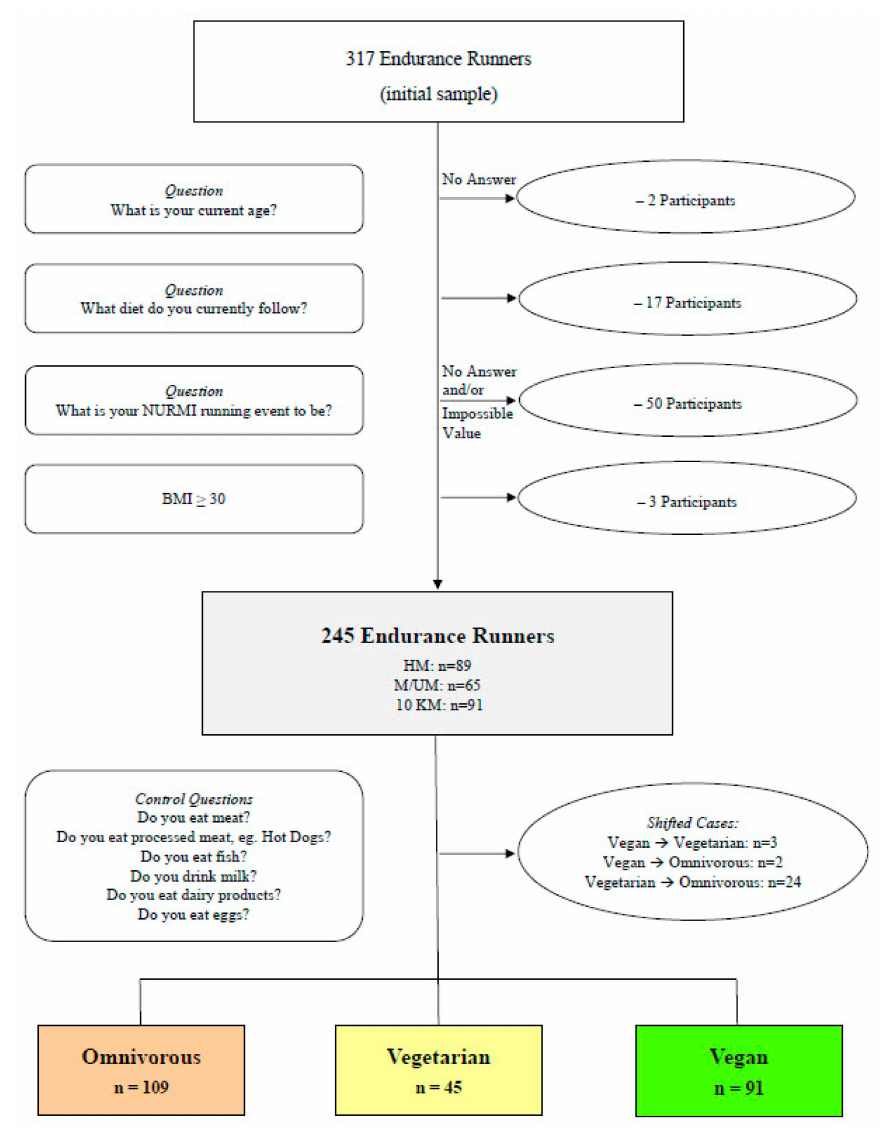
Figure 1. Study enrollment flowchart and dietary subgroup categorization. BMI—body mass index. HM—half-marathon; M/UM—marathon/ultra-marathon; 10 km—10